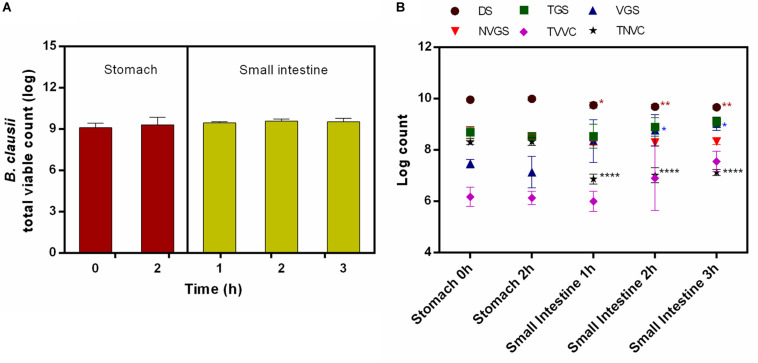
Survival and germination of B. clausii UBBC07 in upper GIT under fed conditions. (A) Total viable count (TVC) enumerated on agar plate. (B) Log count of dormant spores (DS), total germinating spores (TGS), viable germinating spores (VGS), non-viable germinating spores (NVGS), total viable vegetative cells (TVVC), and total non-viable vegetative cells (TNVC) estimated by flow cytometry. Data are expressed as average ± SD of three independent replicates. *p < 0.05, **p < 0.01, and ****p < 0.0001.